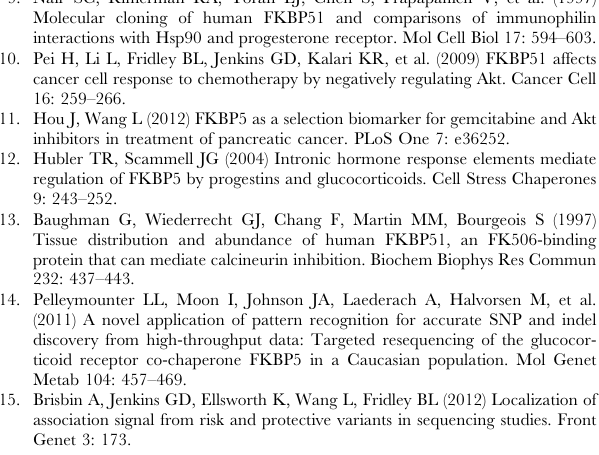
Table S4 Oligonucleotide sequences for site-directed Table S5 Novel insertions/deletions (Indels) detected Table S6 List of top window SNPs from sliding